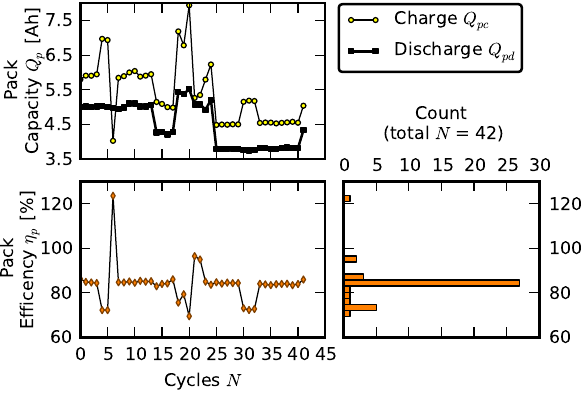
Figure 15. Coulombic efficiency of a pack during cycling (Scenario 2).